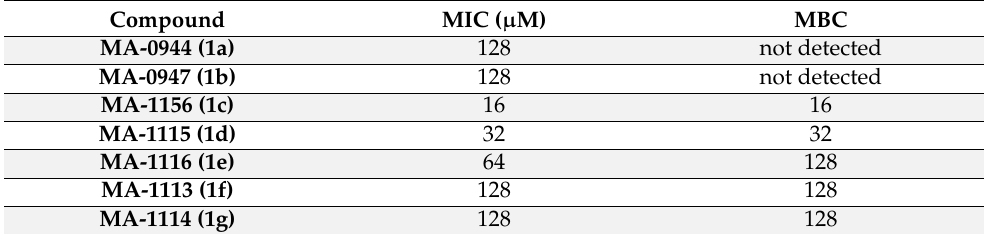
Table 2. Determination of the MIC, and MBC ( µ M) of the tested fluoroarylbichalcophene derivatives ( 1a – 1g ) against S. aureus